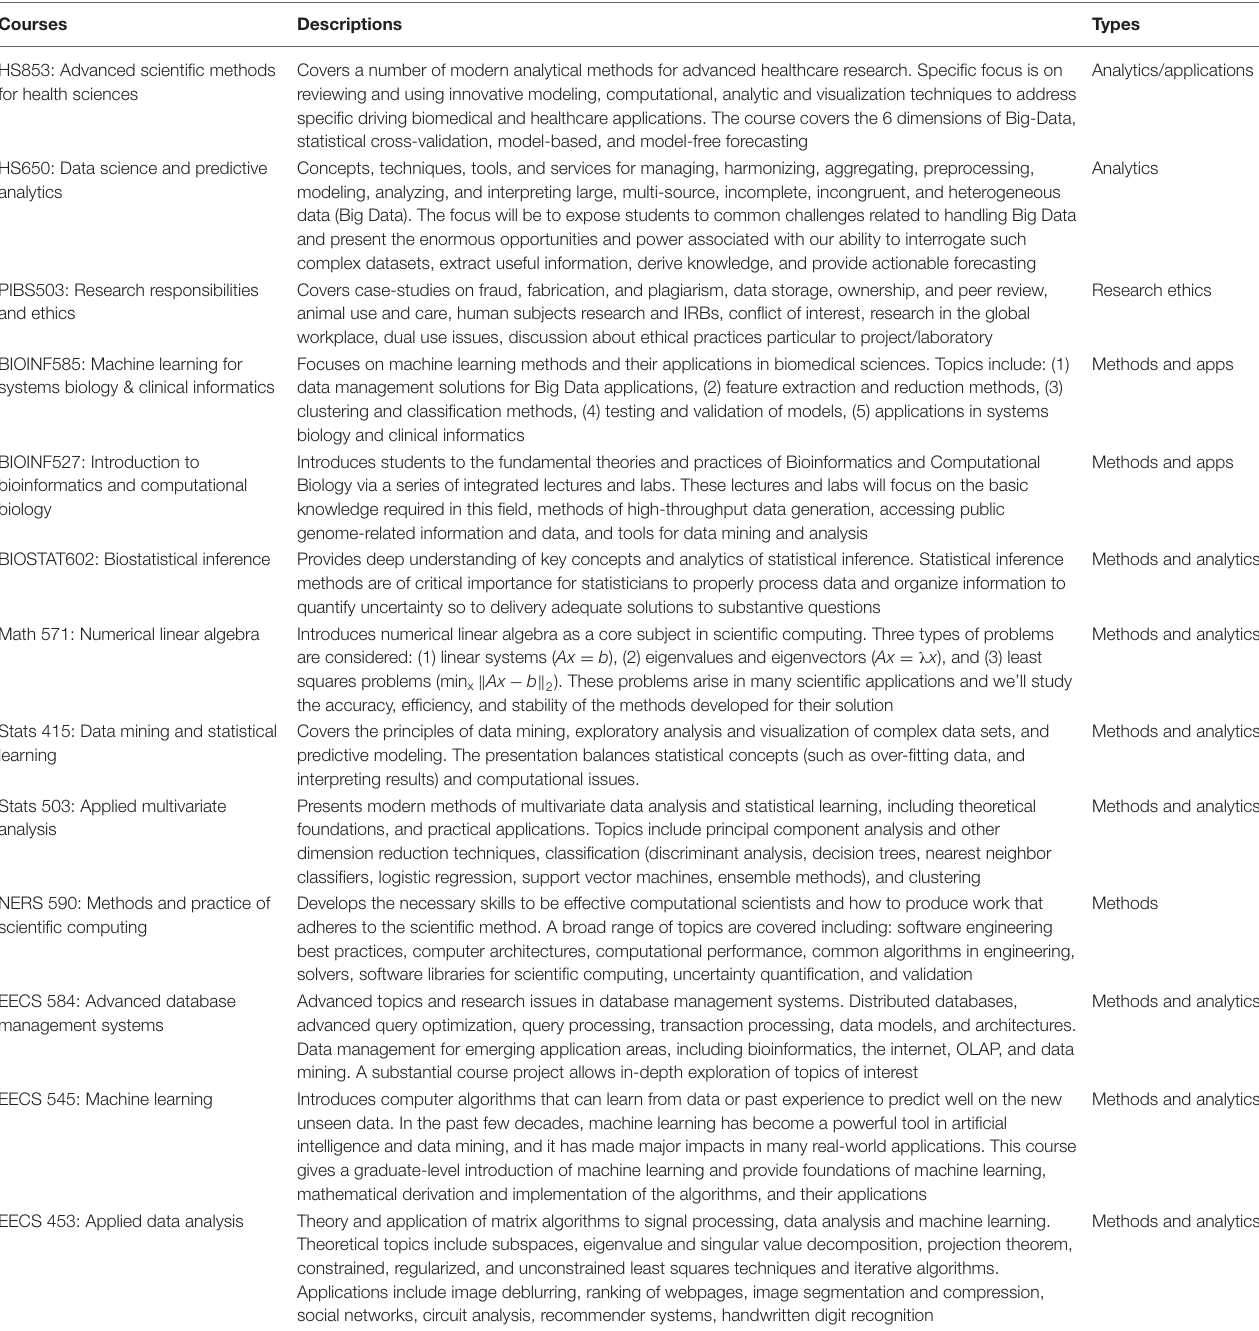
TABLE 2 | Exemplary courses at the University of